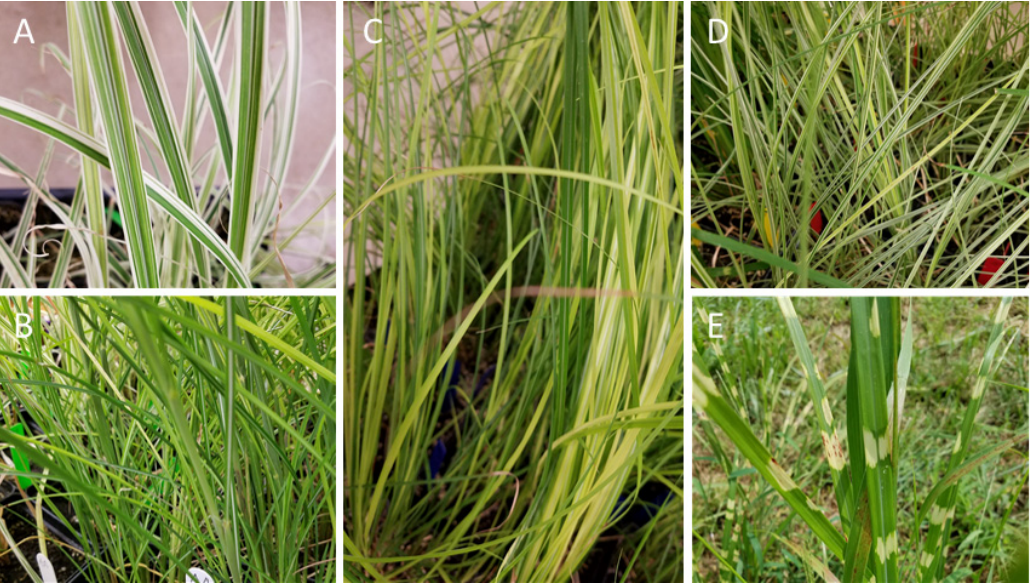
Figure 5. Miscanthus sinensis cultivars used in the study: ( A ) “Dixieland”: linear leaves with tapered tips, serrate margins, and white/silver midribs; ( B ) “Autumn Anthem”: grassy green leaves with pointy white spines; ( C ) “Gracillimus”: narrow dark green leaves with white midribs; ( D ) “Morning Light”: bright green leaves with creamy white margins, and ( E ) “Zebrinus”: green leaves with horizontal soft yellow rings.